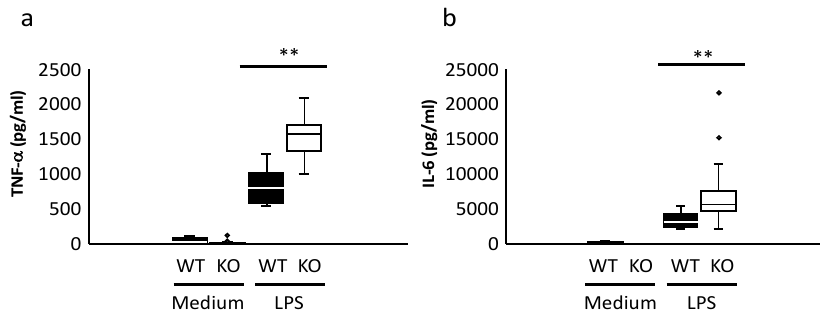
Figure 2. Production of inflammatory cytokines from lipopolysaccharide (LPS)-stimulated BMDCs. BMDCs induced from wild-type (WT) and knockout (KO) mice were stimulated by LPS. After 24 h, the culture supernatants were collected, and the concentrations of TNF- α and IL-6 were determined by ELISA, as described in Materials and Methods. ( a ) TNF- α levels in the culture supernatants of BMDCs from WT (black bar) and KO (white bar) mice. ( b ) IL-6 levels in the culture supernatants of BMDCs from WT (black bar) and KO (white bar) BMDCs. Data in both ( a ) and ( b ) are collected the data of three independent experiments each involving six mice (WT n = 3, KO n = 3) and analyzed by one-way ANOVA with Bonferroni post hoc test. ** p <